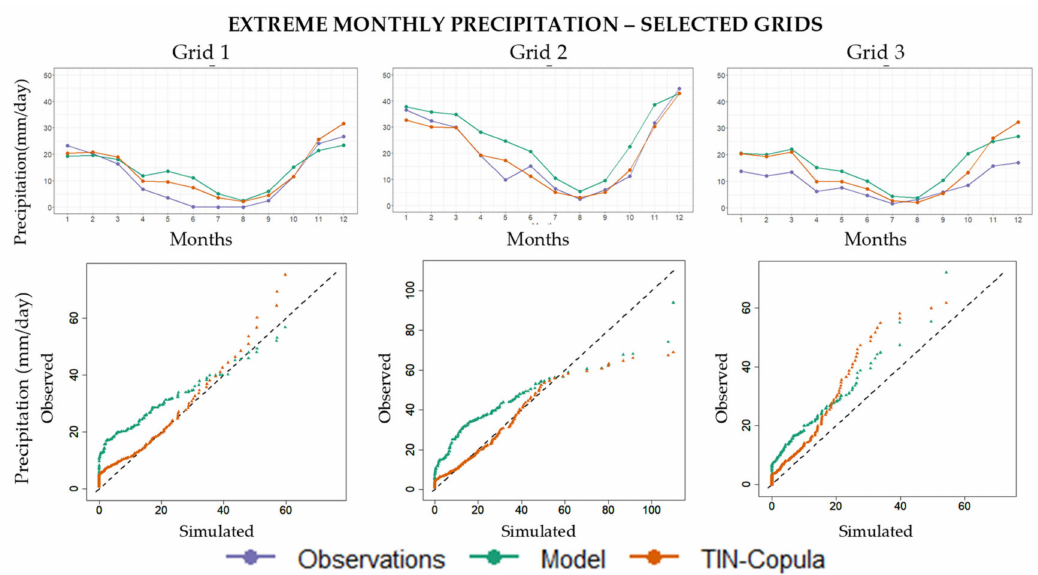
Figure 11. Line plots of the monthly and quantile–quantile plots of the annual extreme precipitation values of the three selected grid points, presented in (Figure 1). ( Grid 1 : coastal grid, Grid 2 : mountainous grid, Grid 3 : continental